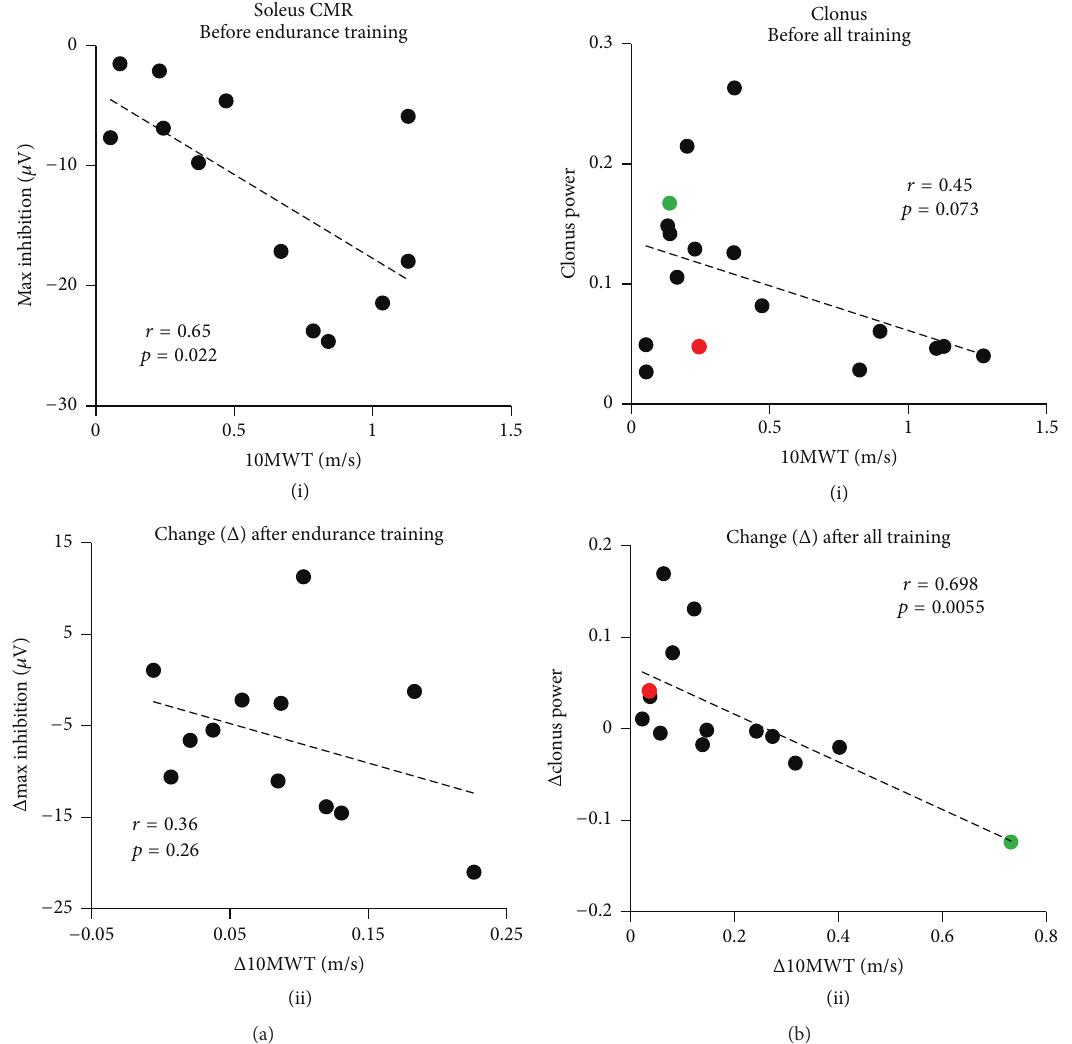
Figure 5: The relationship between reflex excitability and walking outcomes. (a) The inhibition in the soleus CMR was related to walking speed before Endurance Training (i). Change in the maximum inhibition of the CMR as a result of Endurance Training was weakly related to the improvement in walking speed (ii). (b) Clonus in the soleus was weakly related to walking speed before any form of training (i.e., at baseline) (i). Reduction in clonus was significantly related to improvement in walking speed (ii). Green and red data points correspond to P17 and P13, respectively, from Figure